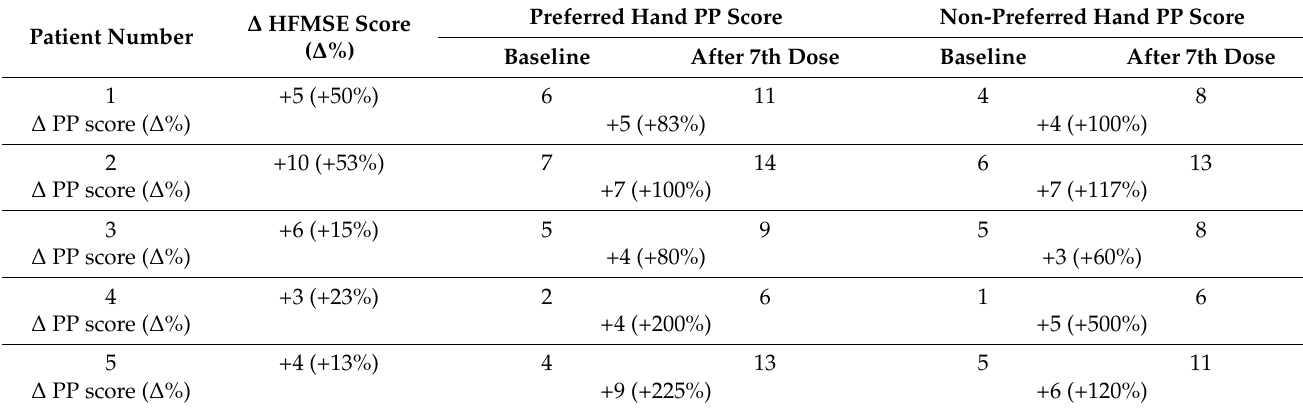
Table 3. Change in Purdue Pegboard scores from